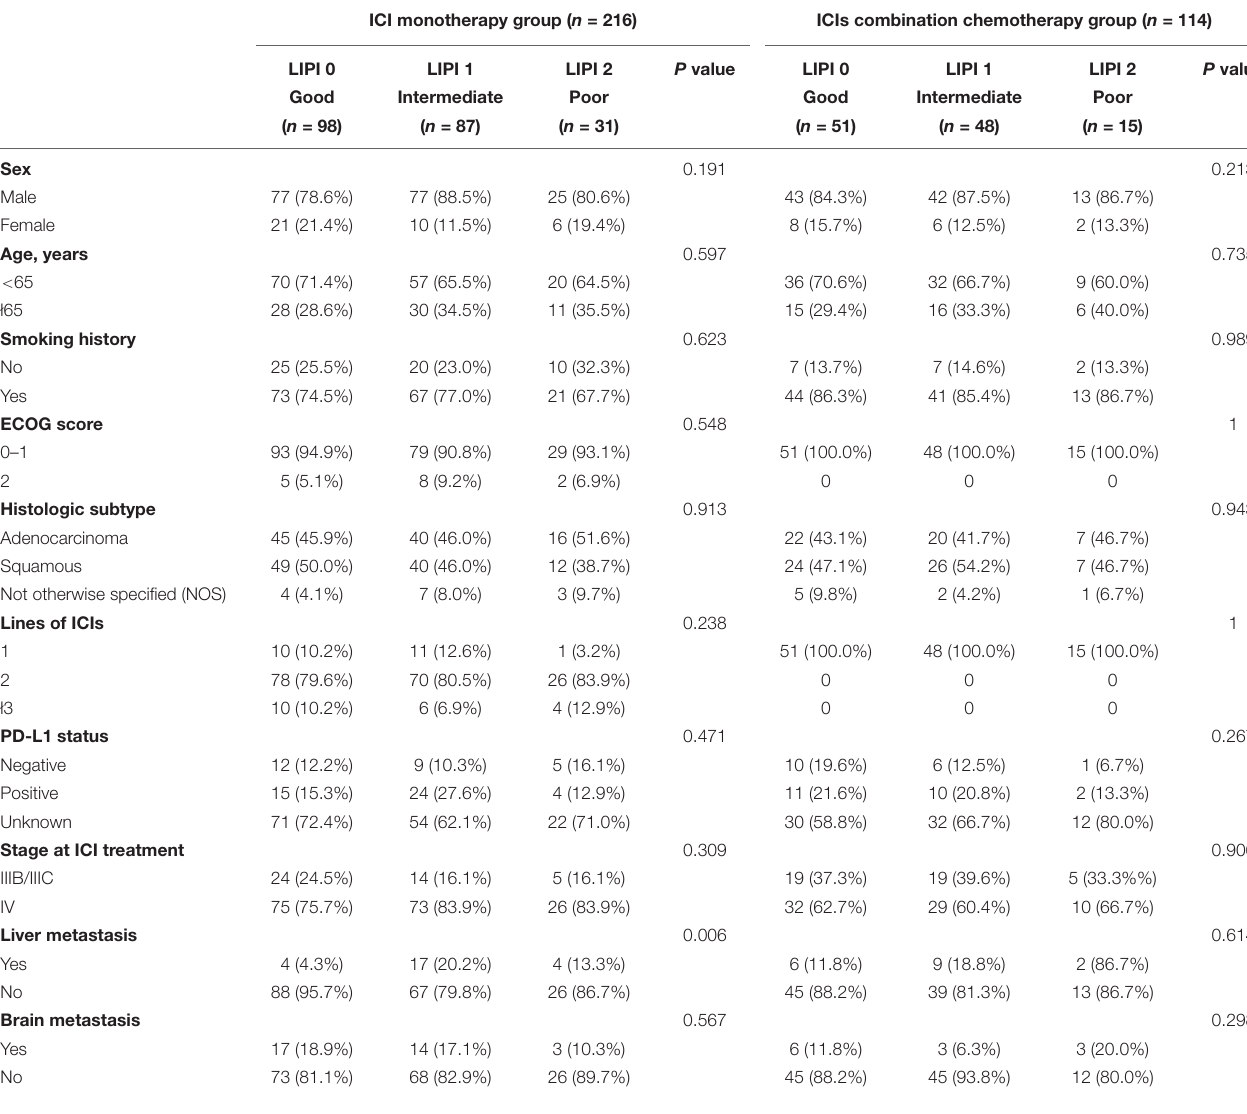
TABLE 1 | Baseline characteristics according to LIPI status in the ICI monotherapy and ICIs combined with chemotherapy groups. ICI monotherapy group ( n =